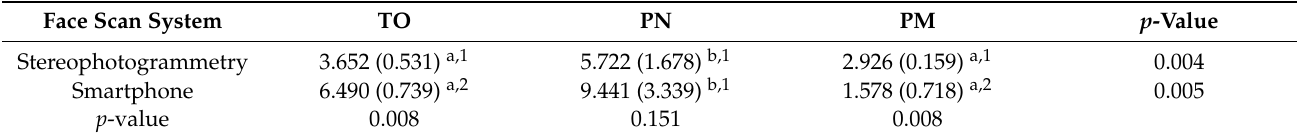
p -value 0.008 0.151 0.008